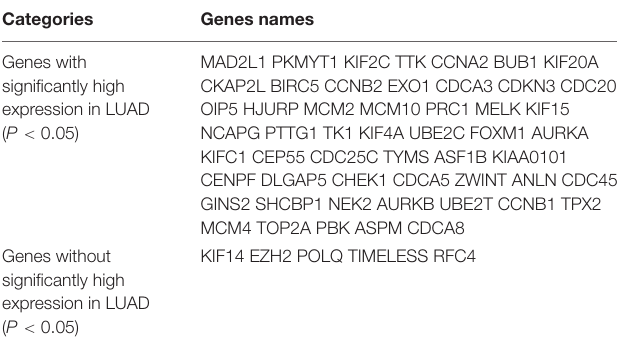
TABLE 3 | Differential expression of 53 genes between LUAD and normal lung